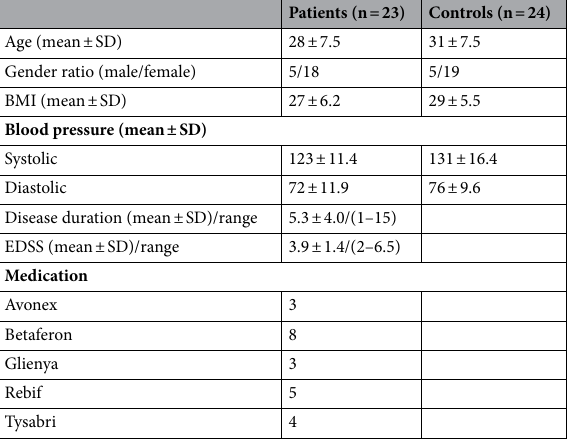
Table 1. Demographic and clinical data of RRMS patients and healthy controls. RRMS relapse-remitting multiple sclerosis, EDSS Expanded Disability Status Scale. Data are presented as number or mean ± standard deviation (SD).